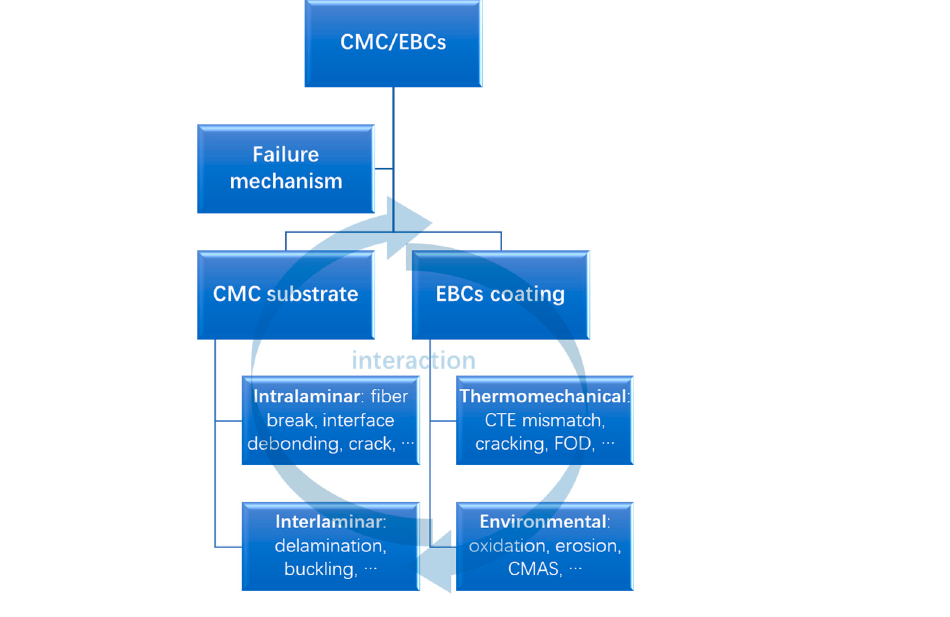
Figure 9. The failure mechanism of the CMC/EBC system.